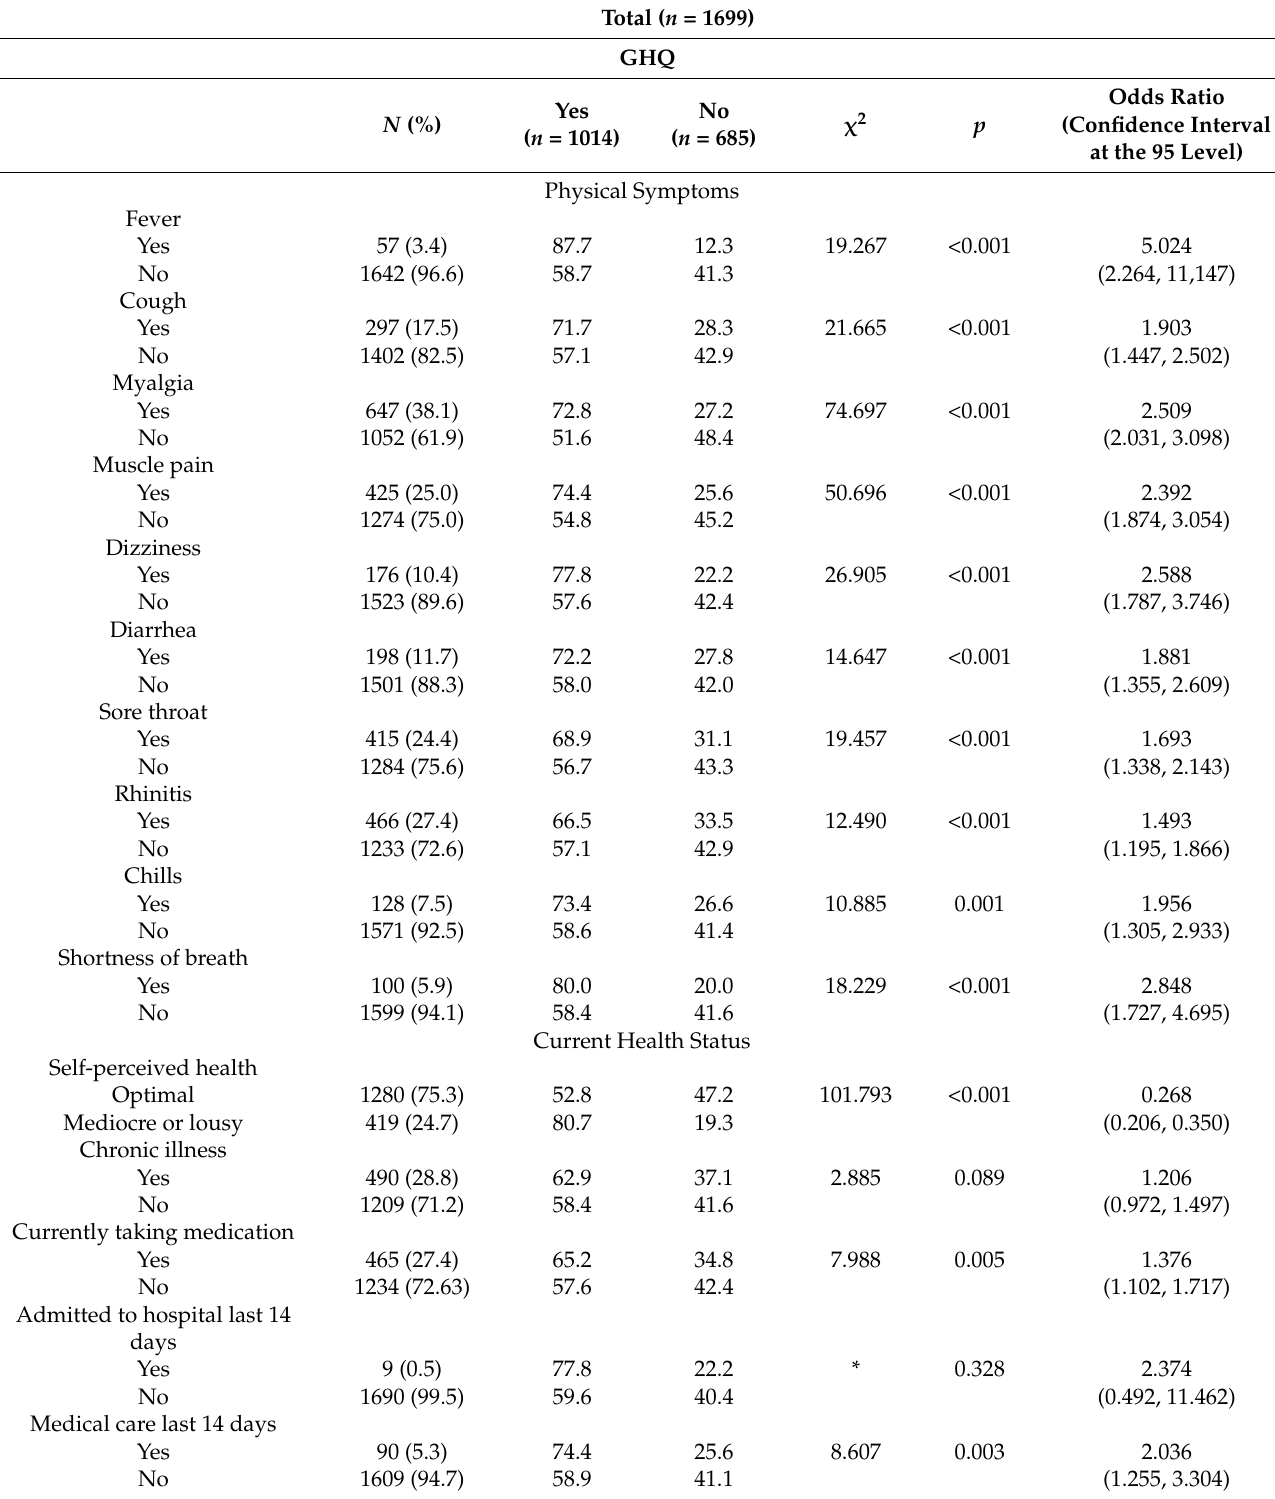
Table 3. Association between physical symptoms and current health status with psychological distress during the pandemic.